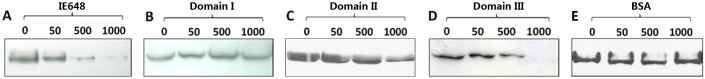
Competition binding assays of IE648 to PM of Asian corn borer.A, Homologous competition binding assays of biotinylated IE648 with different concentrations of unlabeled IE648. The concentration of biotinylated protein is 10 nM, the concentration ratios (molar ratios) between biotinylated protein and unlabeled protein were 1:0, 1:50, 1:500 and 1:1000 (the same below). B, Heterologous competition assays of biotinylated IE648 with different concentrations of unlabeled domain I. C, Heterologous competition assays of biotinylated IE648 with different concentrations of unlabeled domain II. D, Heterologous competition assays of biotinylated IE648 with different concentrations of unlabeled domain III. E, Heterologous competition assays of biotinylated IE648 with different concentrations of unlabeled BSA.